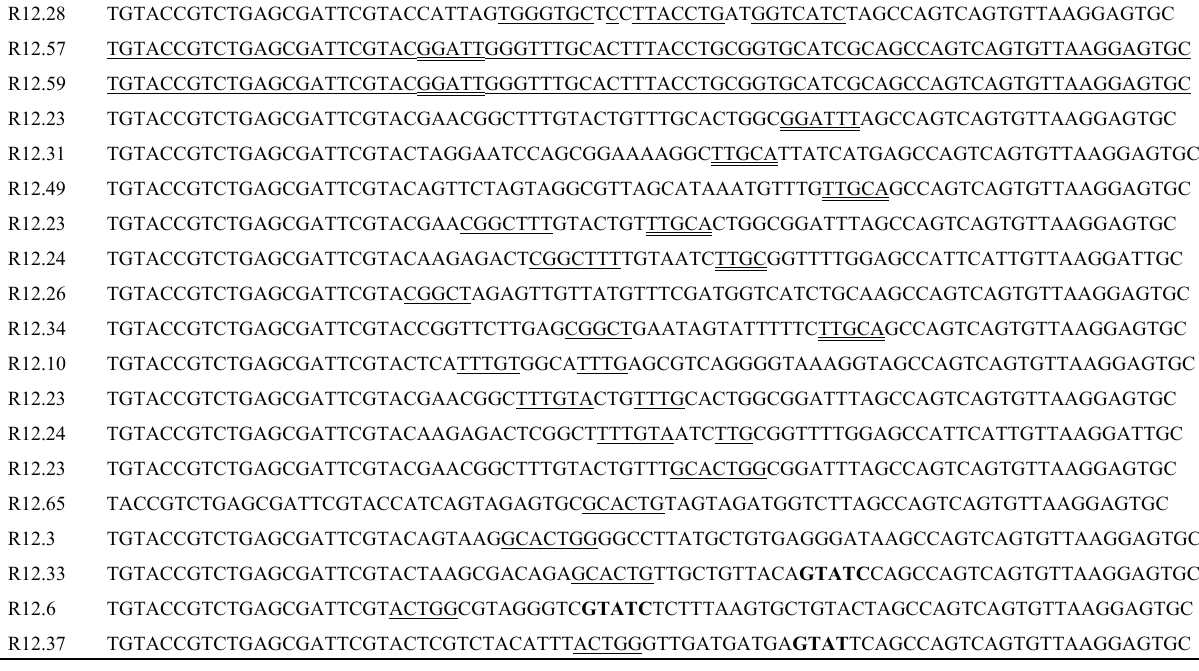
Representative sequence families following Round 12 of SELEX. Families are separated by a space with common sequences underlined and sub-families